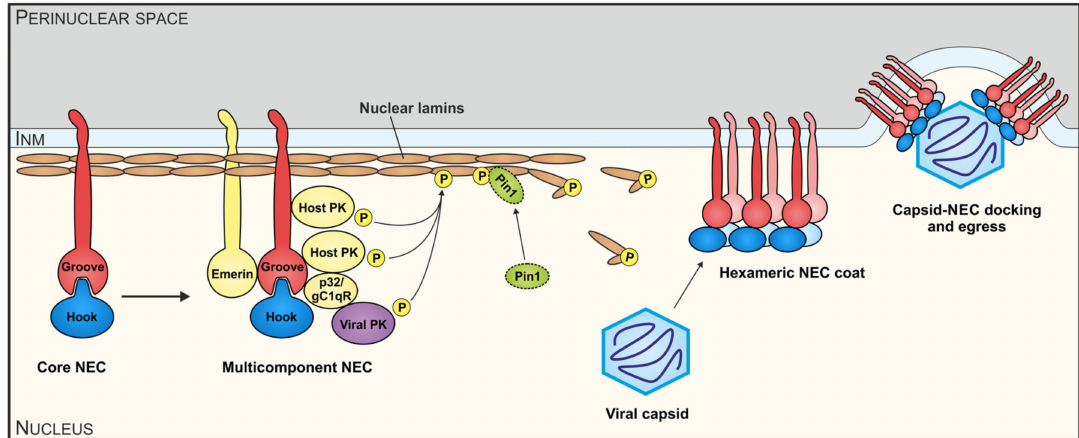
Figure 1. Schematic illustration of functional aspects of the herpesviral nuclear egress complex (NEC) protein interactions and the multiple regulatory aspects of the nuclear egress-specific sequence of events. In essence, the initially formed core NEC and the assembled multicomponent NEC provide the basis for nuclear lamina as well as membrane-rearranging functions and the formation of a hexameric NEC coat, which then serves as a platform for capsid docking. Notably, viral and cellular protein kinases (PKs, i.e., pUL97, PKC, CDK1 and other enzymatic regulators, like the prolyl cis / trans isomerase Pin1), have been identified in the case of human cytomegalovirus (HCMV) (reviewed in Marschall et al. [8]). They represent important active components by site-specific phosphorylation and structural modulation of nuclear lamins A / C and also NEC components. As a result of this concerted activity of the multifunctional NEC, viral nuclear capsids are guided to lamina-depleted areas, where they undergo budding and primary envelopment at the inner nuclear membrane (INM). This scheme represents a refined version of a general herpesviral NEC model as analogously published before for the specific case of HCMV